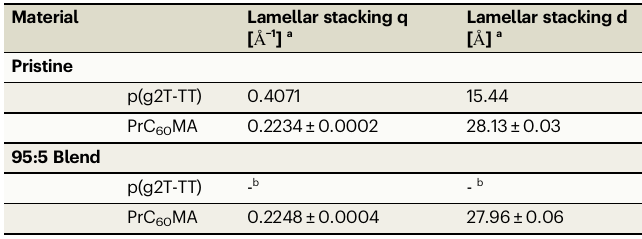
Table 3 | Summary of out-of-plane XRD characteristics